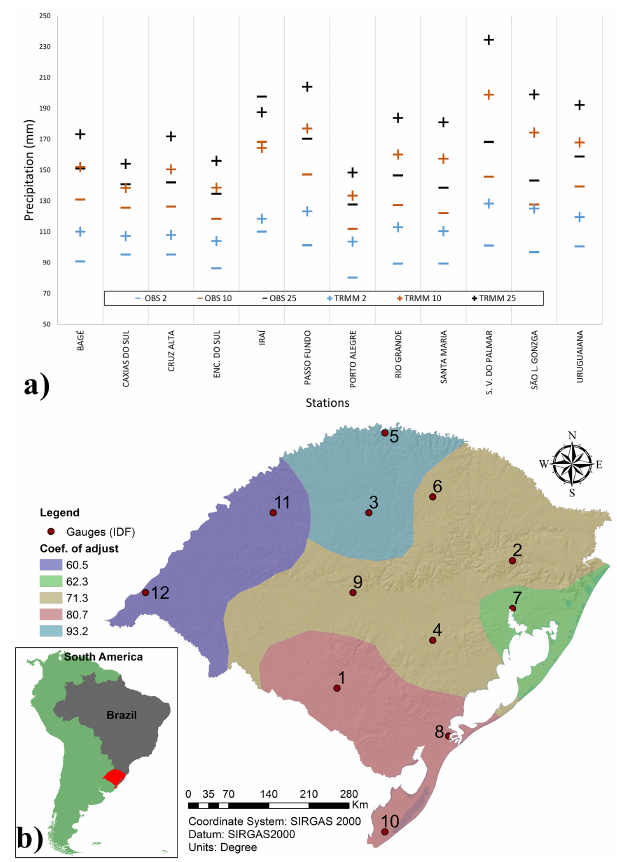
Figure 1. (a) Local variations between TRMM estimative and rain- fall gauges. (b) Regions of maximum precipitation and TRMM ad- justment